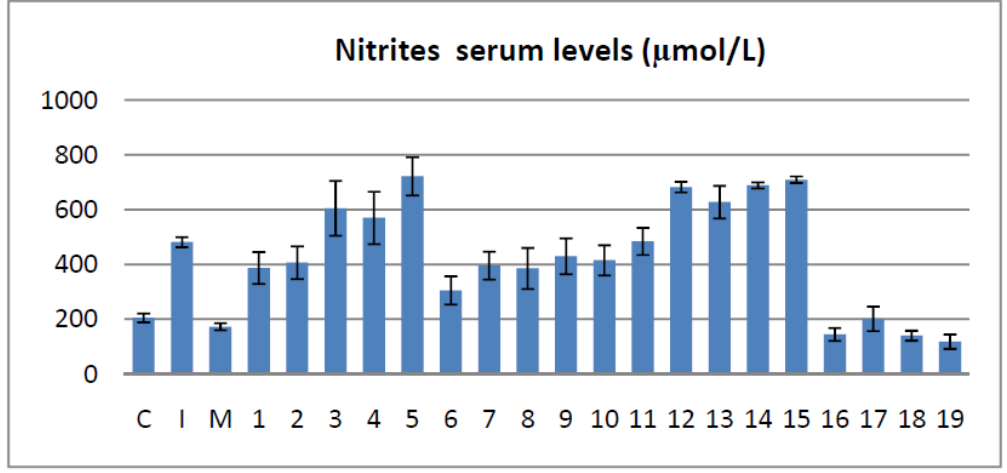
C = negative control; I = inflammation; M =